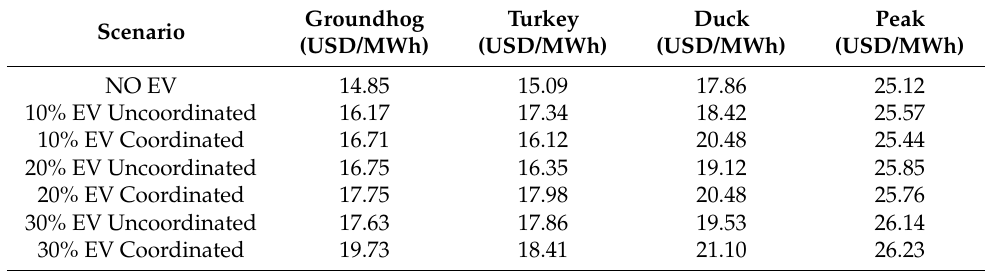
Table 9. Weekly average LMP (USD/MWh) occurring over the entire system (RTS-GMLC).